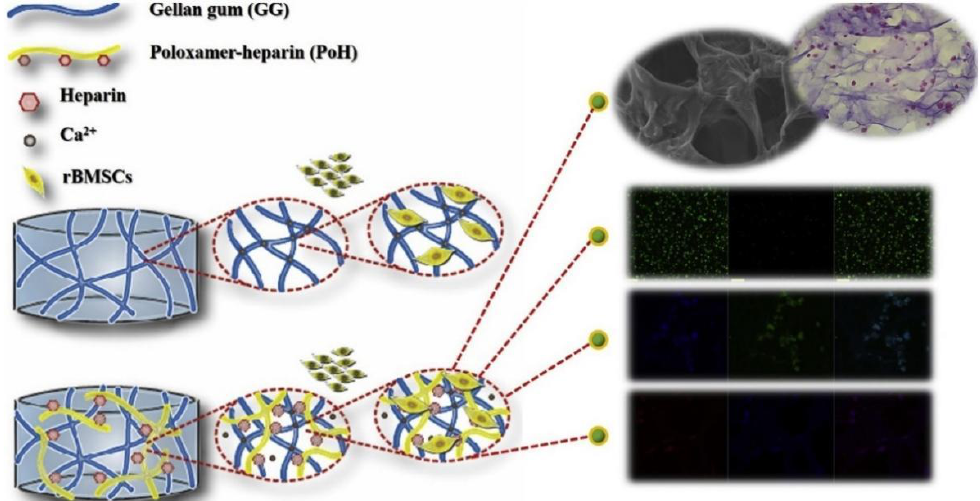
Figure 6. Double network hydrogel system of gellan gum hydrogel and poloxamer heparin hydrogel with rBMSCs encapsulation. The image has been taken from the publication by Choi et al. [64] with